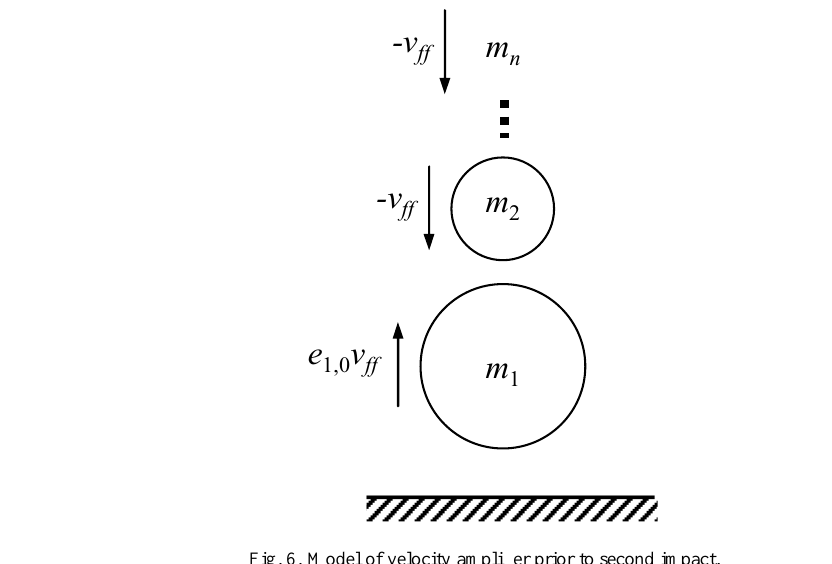
Fig. 6. Model of velocity amplifier prior to second